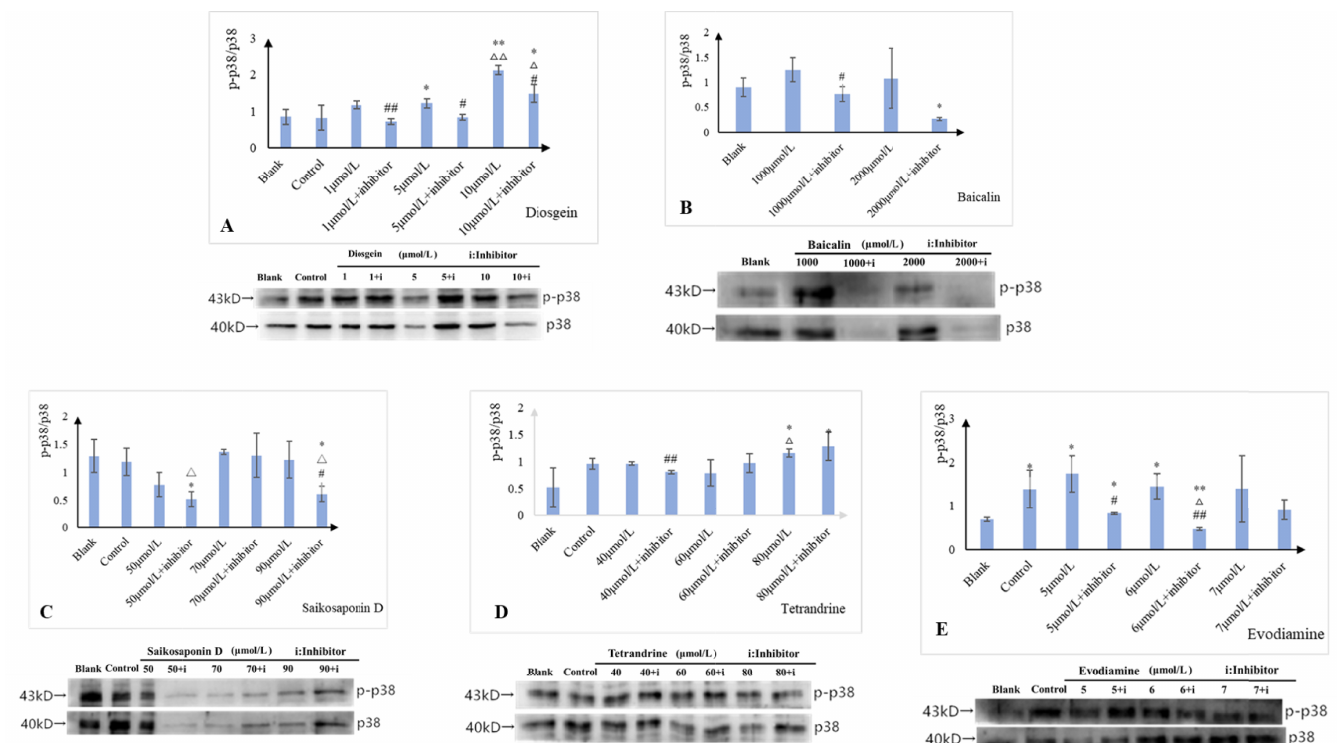
Fig 7. Effects of potential liver injury components on L-02 cells p38 protein expression activity with inhibitor.